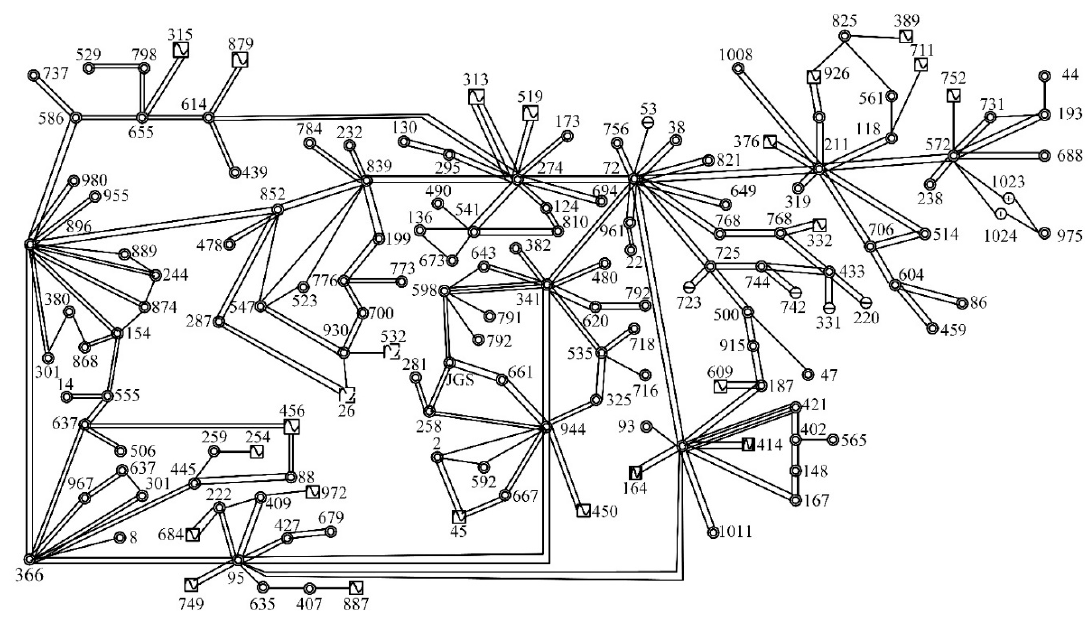
Figure 2. Single-line diagram of the provincial power grid.